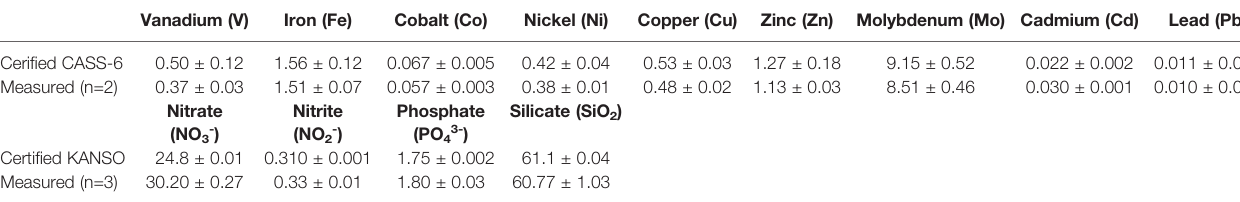
TABLE 1 | Certi fi ed and measured concentrations of Standard Reference material for trace metals (CASS-6, NRC-CNRC) in µg/L and nutrients (KANSO, CRM Japan) in µM, in